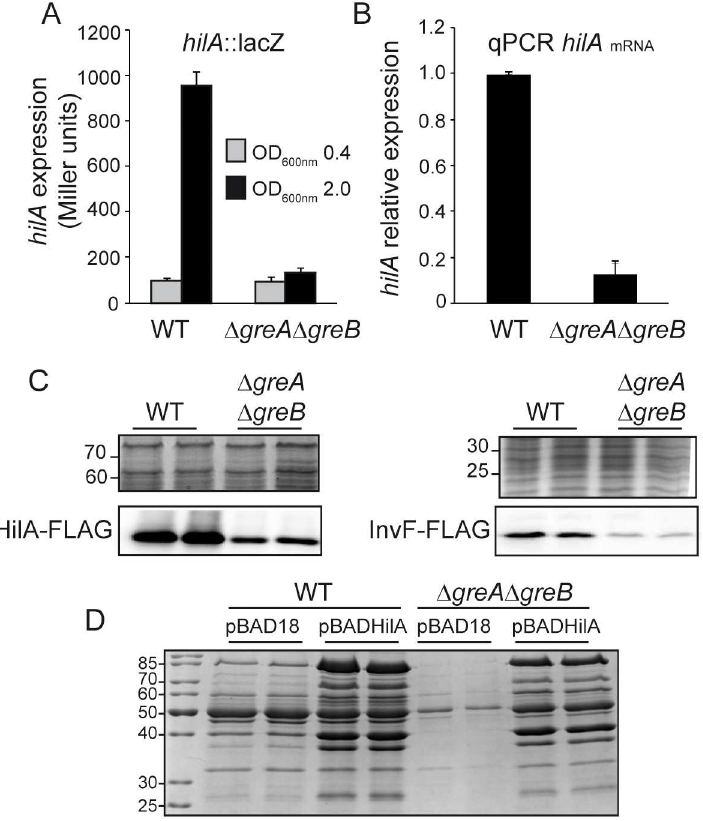
Fig 3. Gre factors are essential for HilA expression. (A) Transcriptional expressionof hilA in WT and Δ greA Δ greB derivative strains. β -galactosidaseactivity from a hilA :: lacZ fusion was assessed in LB cultures grown at 37˚C up to logarithmic(OD 600nm 0.4) and stationary growth phase(OD 600nm 2.0). (B) Relative hilA mRNA quantification by qPCR in WT and Δ greA Δ greB derivative strains. Results are normalized with gapA (GAPDH) as an endogenous control. RNA sampleswere extracted from cultures of WT and Δ greA Δ greB derivative strains grown in LB at 37˚C up to an OD 600nm 2.0. In A and B, a bar shows the arithmetic mean of experimental results and the error bar indicatesthe standard deviationfrom three biological replicates. (C) Immunodetection of HilA-FLAG (lower left panel)and InvF-FLAG (lower right panel)proteins in wholecell extracts from cultures of WT and Δ greA Δ greB derivativestrains grown as in B. The upper panelsare sections of Coomassie stainedgels as loadingcontrols. (D) Cell-free supernatants of LB cultures, grown at 37˚C up to an OD 600nm of 2.0, of WT and Δ greA Δ greB derivative strains carrying either pBAD18or pBADHilA.Arabinose (0.02%) was added in all cultures. Extracts were analyzedby Coomassie blue stained 12.5%